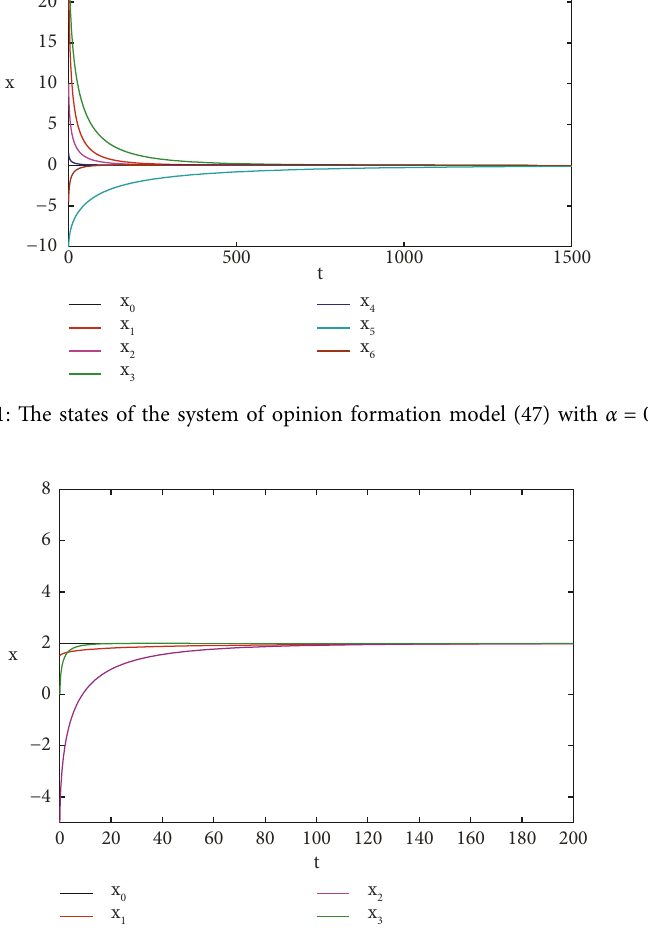
Figure 2: The states of the system of opinion formation model (48) with α � 0 .